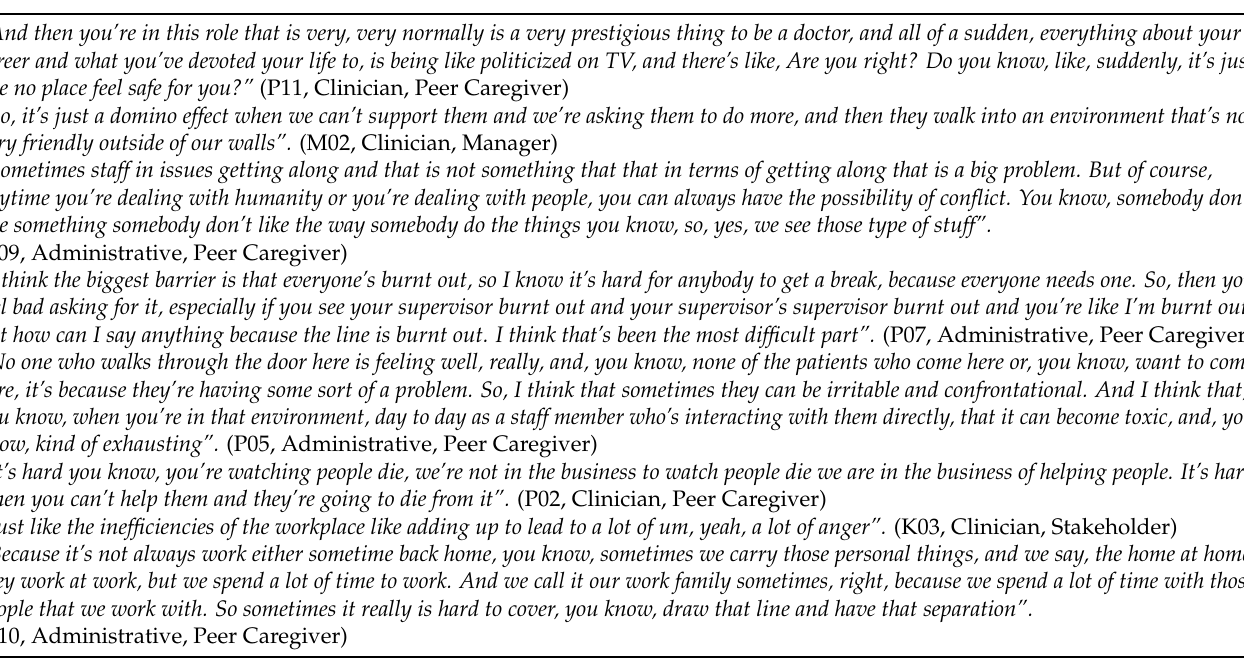
Figure 2. Internal and external factors contributing to staff stress and burnout. Table 4. Workplace and professional stressors contributing to